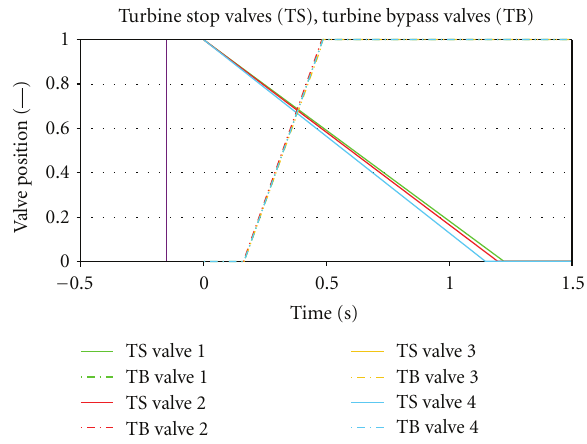
Figure 14: Dynamic of the closing and opening of TS and TB.